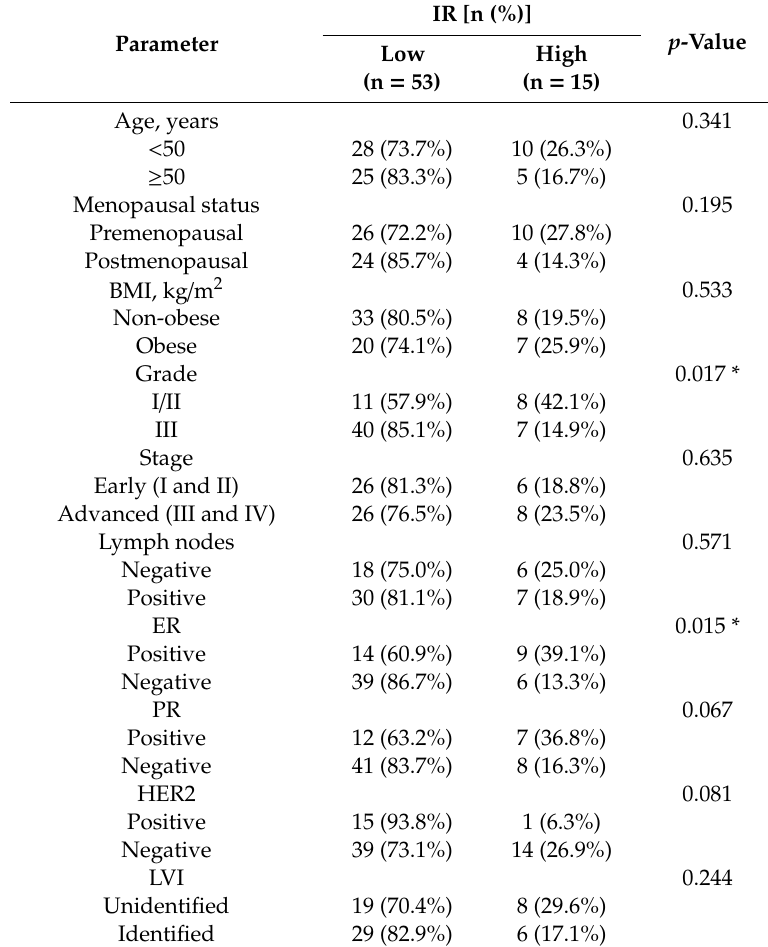
Table 2. Expression of IR (insulin receptor) and its association with clinicopathologic parameters in breast cancer patients (n = 68).